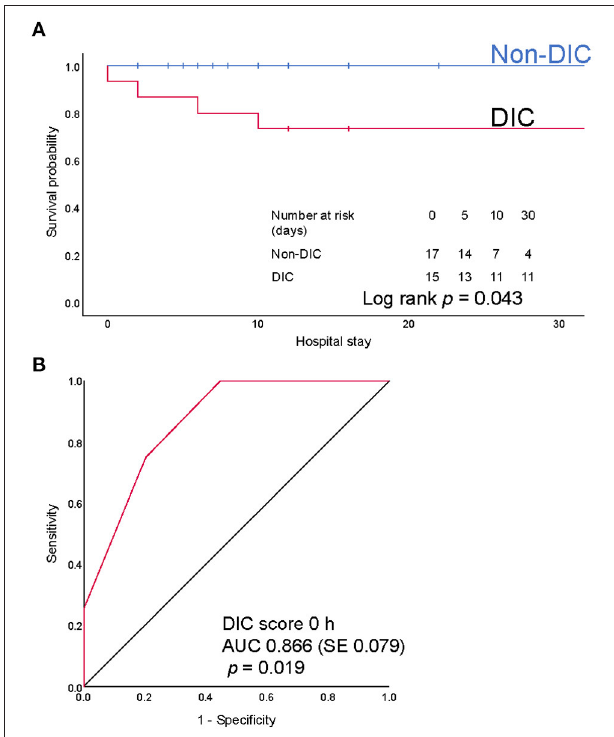
FIGURE 4 | (A) Kaplan-Meier survival provability curves for mortality during hospitalization. Numbers at risk represent the number of patients with isolated traumatic brain injury (iTBI) with or without disseminated intravascular coagulation (DIC) at risk of death on the indicated days. (B) Receiver operating characteristics (ROC) curves of the DIC score immediately after arrival at emergency department. AUC, area under the ROC curve; SE, standard error.